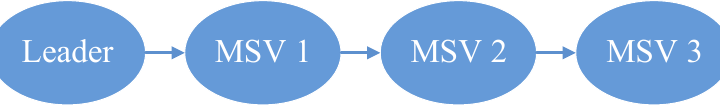
Figure 4. Communication graph among four